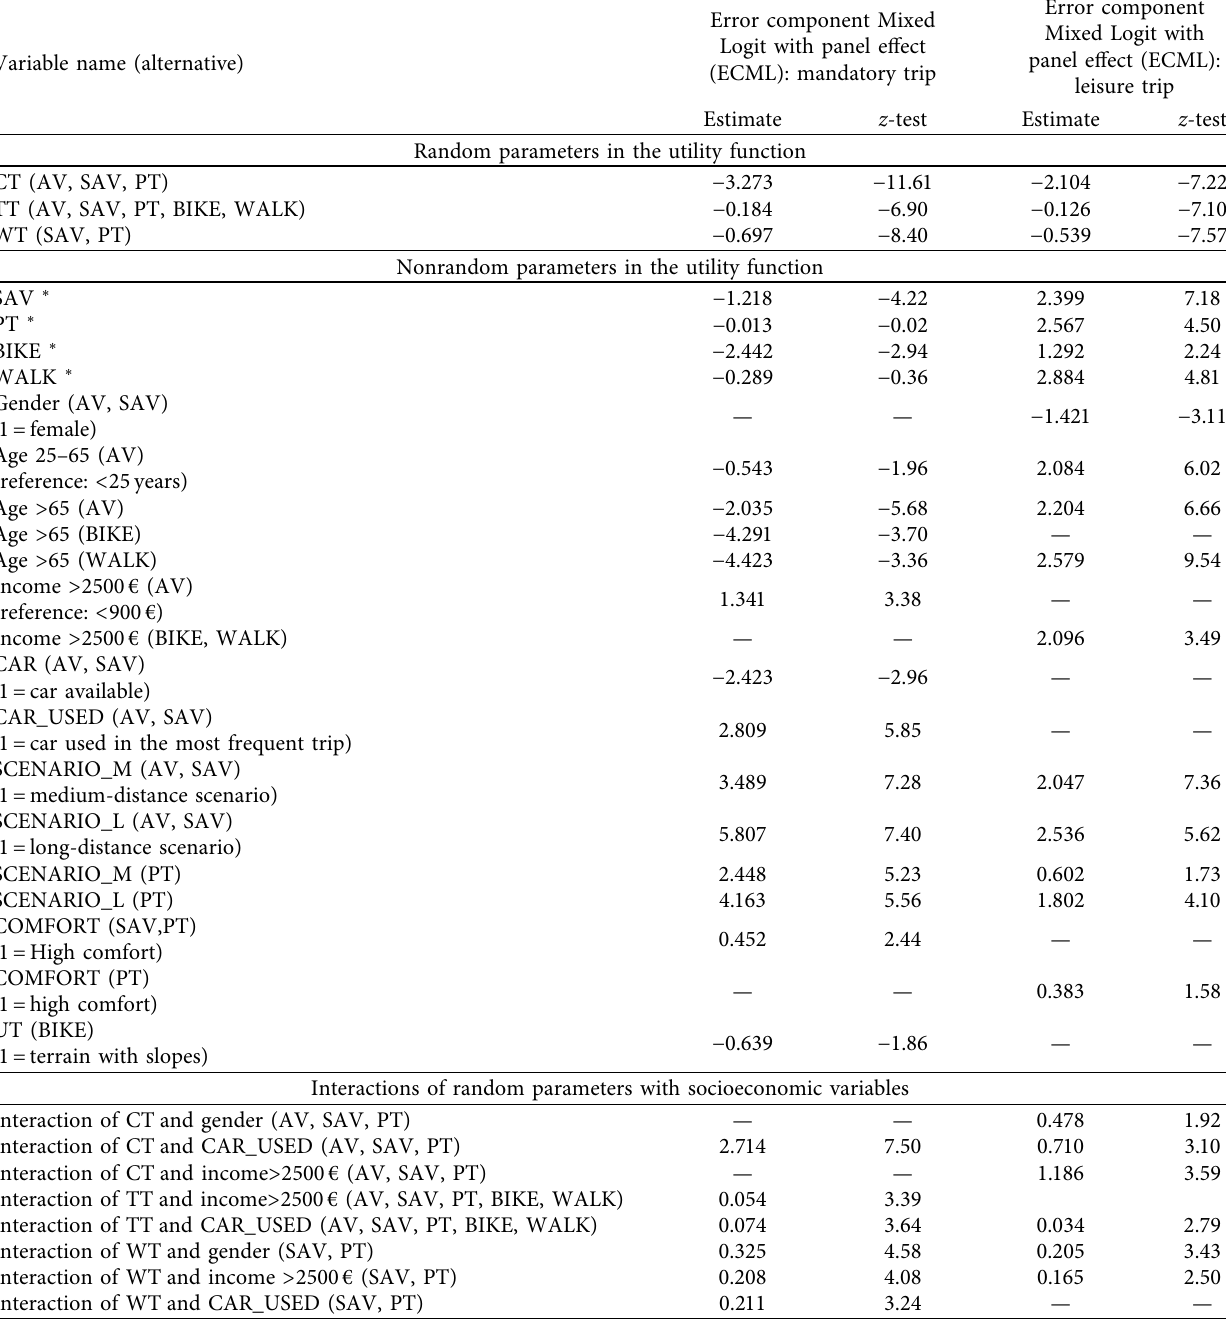
Table 5: Error component Mixed Logit models (mandatory and leisure